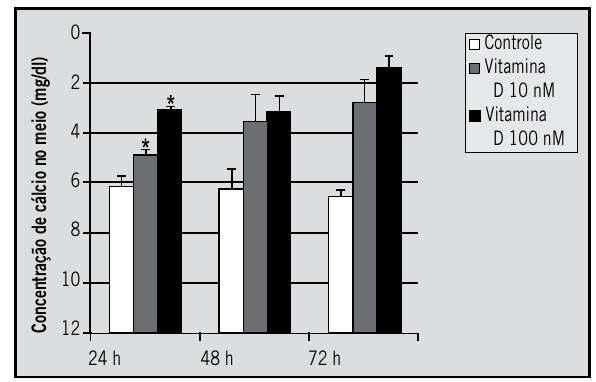
Figura 1 – Concentração de cálcio no meio de cultura nos diferentes grupos e nos intervalos de 24, 48 e 72 horas * p =